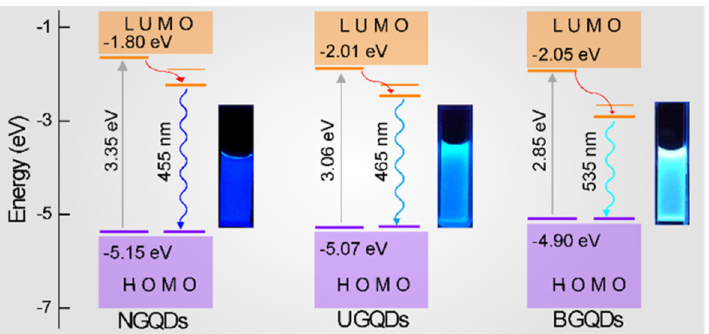
Figure 6. Experimentally measured HOMO and LUMO energy levels for nitrogen-doped GQDs (NGQDs), undoped GQDs (UGQDs), and boron-doped GQDs (BGQDs) and their emission wavelengths. Reprinted with the permission of Reference [77]. Copyright 2018 American Chemical Society.